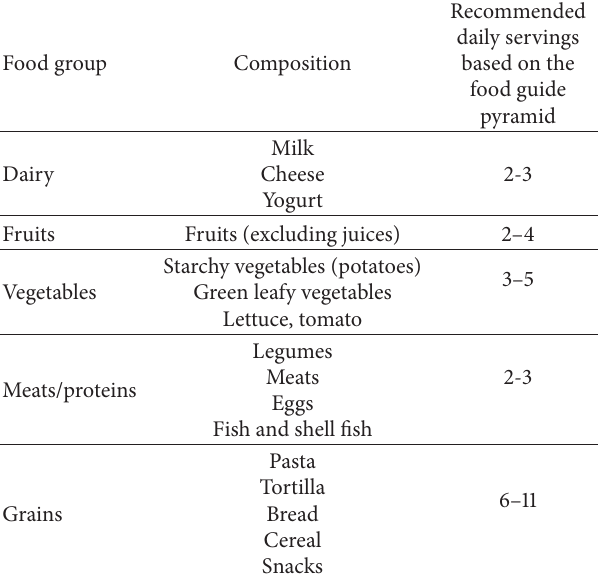
Table 1: Composition of food